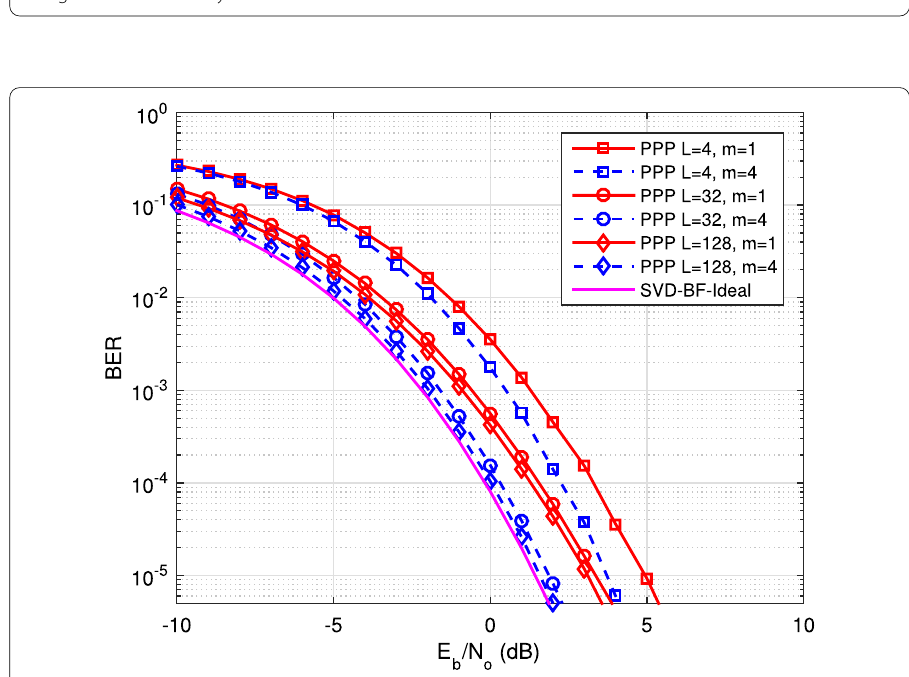
Fig. 8 BER comparison with L 1 1 (RCPA) and m and m = theoretical SVD-BF BER with ideal channel